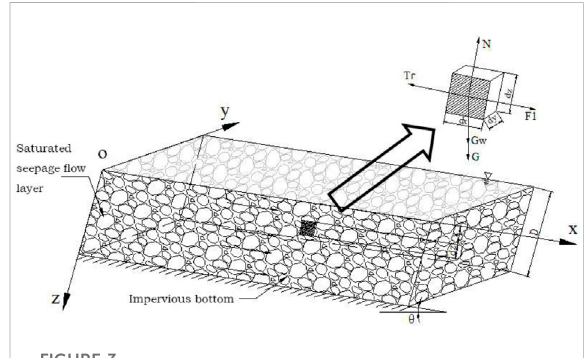
FIGURE 3 The mechanical analysis diagram of the solid materials unit under saturated seepage fl ow